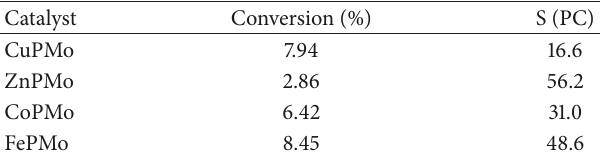
Table 4: Effect of counter ion on the PO conversion and PC selectivity. Reaction conditions: 𝑃 ( CO = 5 bar; reaction temperature 2 ) 65 ∘ C; reaction time = 7 h; 𝑚 (catalyst) 0.150 g; 𝑚 (TEABr: